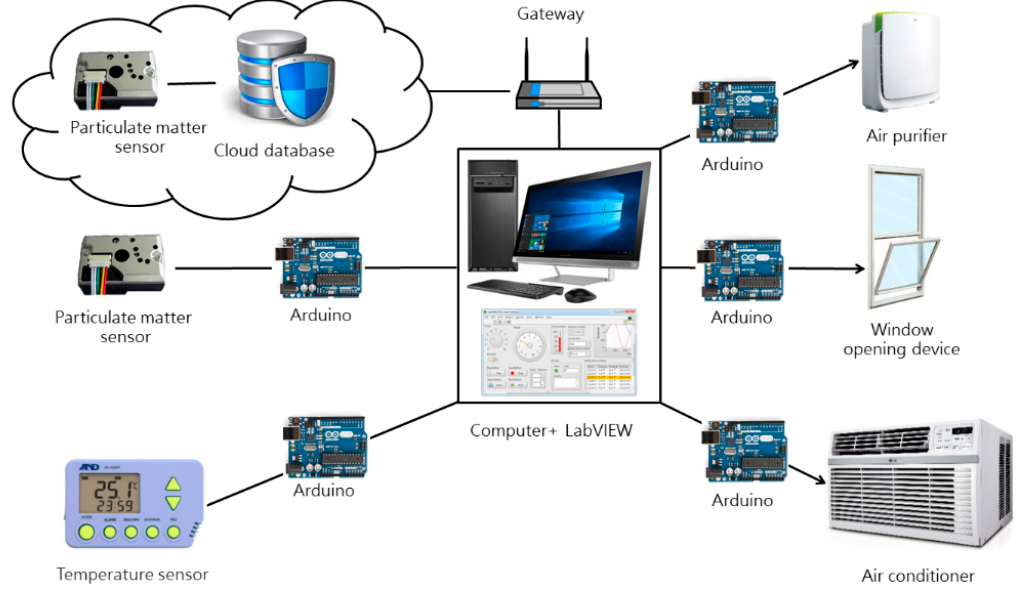
Figure 11. A multi-agent cooperation system.